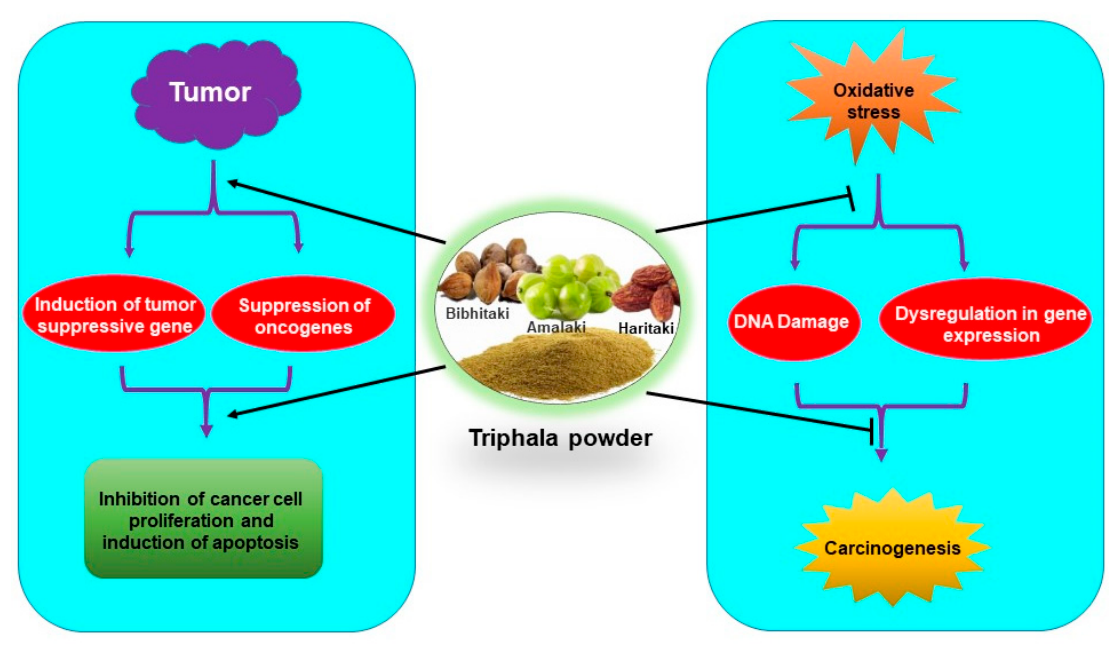
Figure 4. Antioxidative and chemopreventive / chemotherapeutic properties of Triphala.